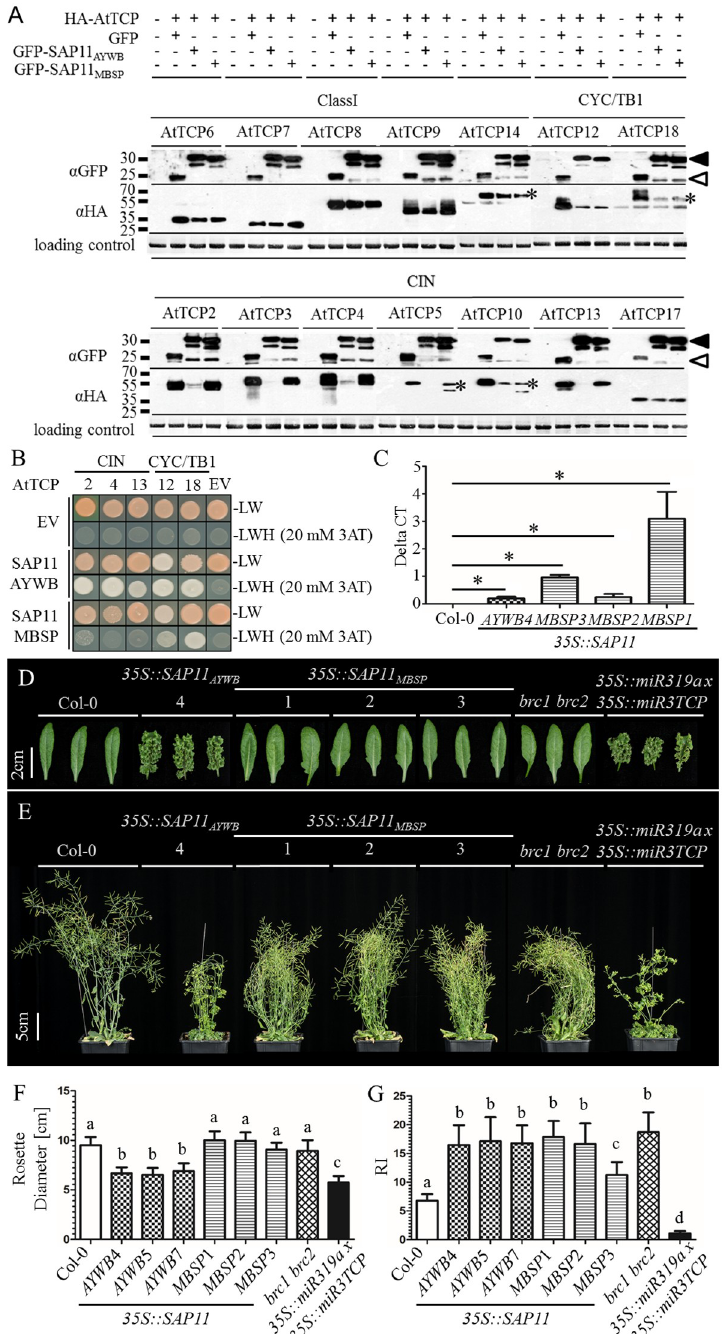
Fig 1. SAP11 AYWB and SAP11 MBSP interactions with A . thaliana TCP transcription factors. (A) Western blots of A . thaliana protoplast destabilization assays; SAP11 AYWB and SAP11 MBSP destabilize the CYC/TB1 TCPs BRC1 (AtTCP18) and BRC2 (AtTCP12) and SAP11 AYWB also all class II CIN-TCPs, whereas the SAP11 homologs did not destabilize class I TCPs. GFP-tagged SAP11 (filled arrowheads) or GFP alone (open arrowheads) and HA-tagged TCPs were detected with specific antibodies to GFP and HA, respectively, as indicated at left of the blots. � band of the correct size in case of multiple bands on the blots. Loading controls: Amidoblack-stained large RUBISCO subunit. (B) Yeast two-hybrid assays of interactions of SAP11 AYWB with CIN and CYC/TB1-TCPs and SAP11 MBSP with CYC/TB1-TCPs. Positive interactions are visible by yeast growth on SD-LWH selection media containing 20 mM 3-Amino- 1,2,4-triazole (3AT). EV = empty vector controls showing absence of auto activations. (C) qRT-PCRs of transcripts